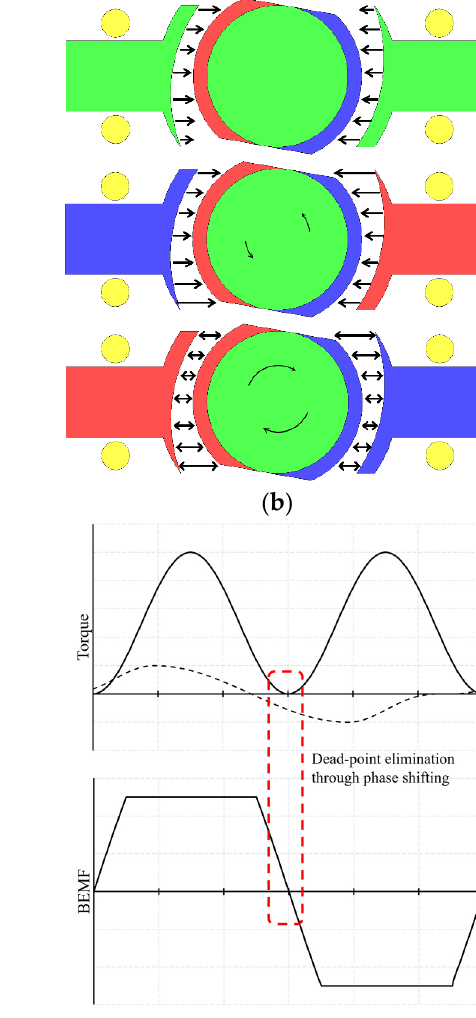
Table 1. Specifications of the single-phase BLDC motor.